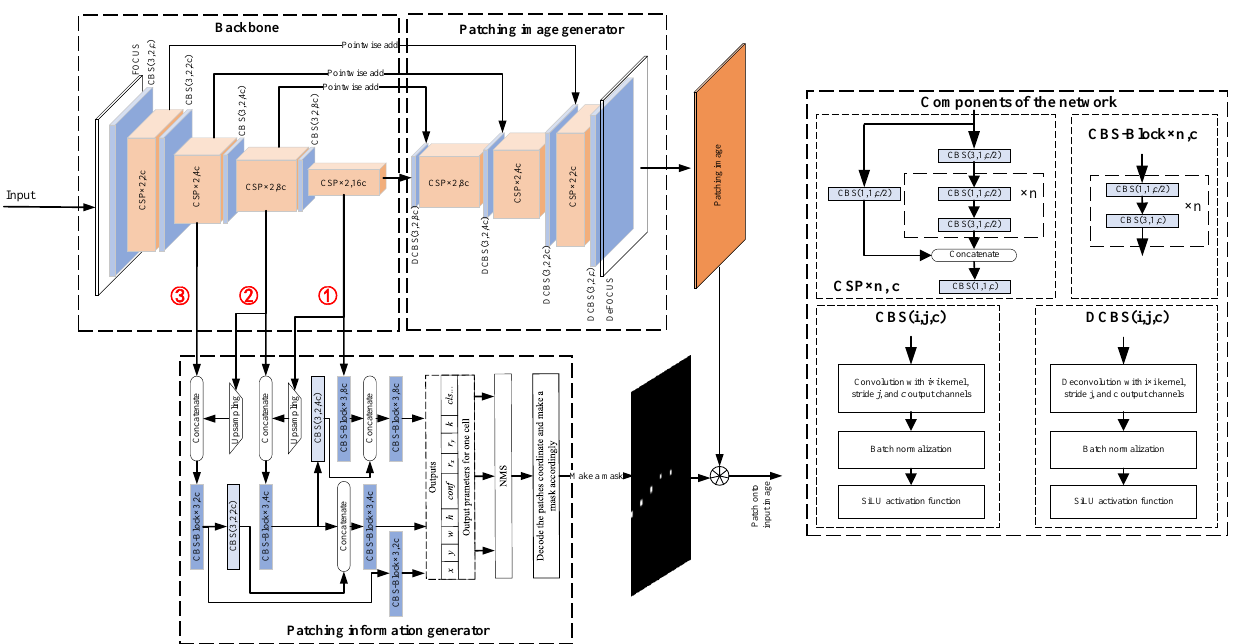
Figure 2. Adaptive adversarial patch-generating network. The main structure of the network consists of three parts, (1) the backbone used to extract features from the input; (2) the patching image generator that uses the features extracted by the backbone to generate a patching image with a size identical to the input image; (3) the patching information generator that uses the features extracted by backbone to generate mask on the patching location. Finally, the mask on the patching image is used to select the corresponding patch out from the patching image and patch it on the objects. The red circled numbers represent different scaled branches for ablation experiments in Section 3.3.